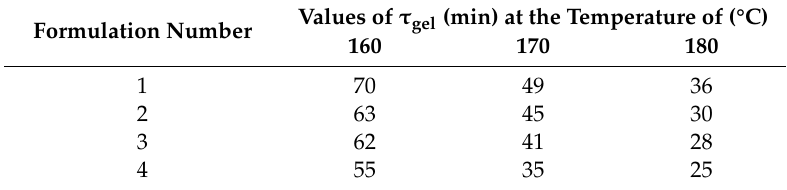
Table 3. Values of gel time ( τ gel ) for formulations 1 − 4 at di ff erent curing temperatures. Values of τ gel (min) at the Temperature of (°C) Formulation Number